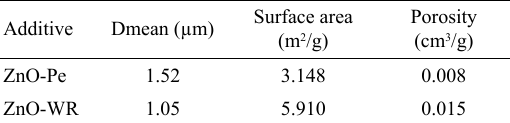
Figure 2. Variation in tensile strength at rupture of aged and unaged ZnO loaded TPE compounds. Error bars means ± SD of ten replicates.